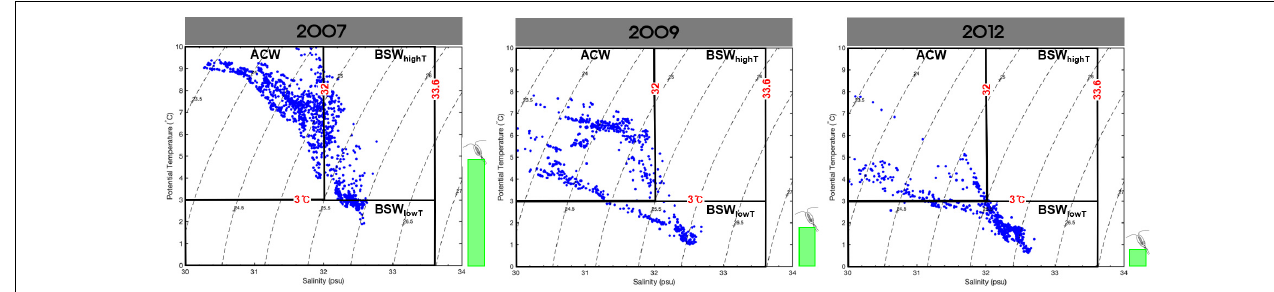
FIGURE 5 | A2 mooring T-S Diagram for September 2007, 2009, and 2012. The green bars are relative abundance of Pacific